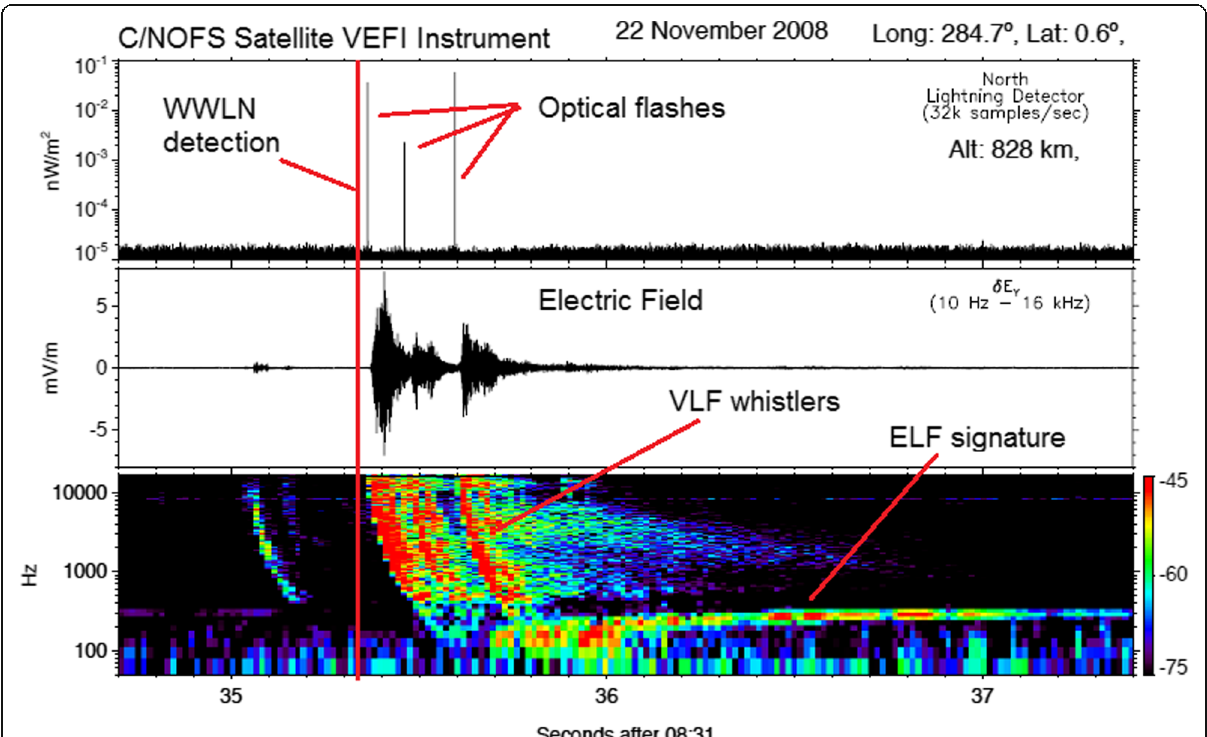
Fig. 5 A single (multiple) lightning flash recorded by the C/NOFS satellite on Earth in multiple ways that have only separately been seen on Venus. Three brief optical flashes (top) are recorded, the first near-synchronous with a stroke detection by the ground-based VLF World-Wide Lightning Network (WWLN), shown in the red line. Electric field antennas on the satellite then showed a waveform (middle) that can be decomposed in the spectrogram (bottom) into whistlers in the VLF range (kHz to 10 s of kHz), similar to the VLF noise recorded by the Venera landers, and ELF waves of a few hundred Hertz (which may be whistler-mode) in the ionospheric plasma, similar to those recorded by Pioneer Venus and Venus Express. Figure